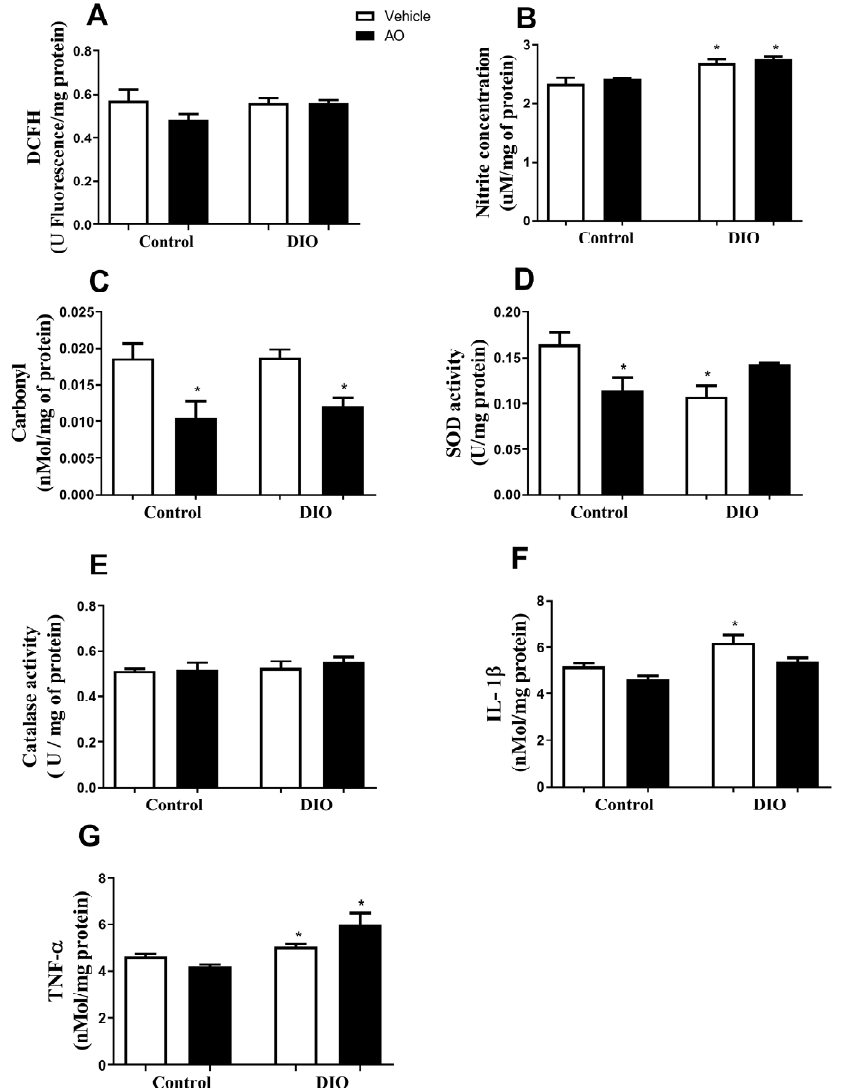
Figure 7. Effects of avocado oil (AO) supplementation on reactive species production, oxidative damage, antioxidant enzymes activity and cytokines levels in the hippocampus of mice with diet-induced obesity (DIO). ( A ) 2 (cid:48) -7 (cid:48) -Dichlorofluorescin (DCFH) levels. ( B ) Nitrite levels (* DIO > control, control + AO and